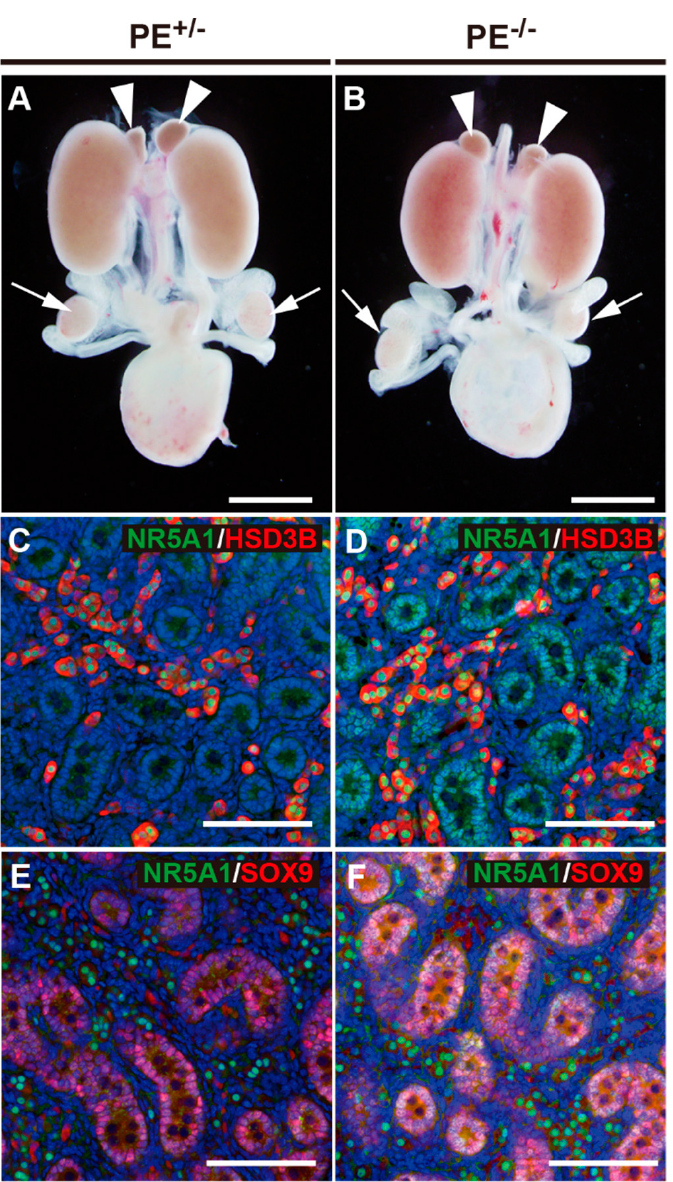
Figure 2. Fetal masculinization was not affected in PE − / − mice. ( A , B ) Macroscopic observation of the urogenital systems in the control mice ( A ) and PE − / − mice ( B ). Arrowheads indicate adrenal glands, whereas arrows indicate testes. ( C , D ) Double staining of the testis with antibodies for NR5A1 (green) and HSD3B (red). ( E , F ) Double staining of the testis with NR5A1 (green) and SOX9 (red) antibodies. Scale bar: 2 mm in ( A , B ), 100 μ m in ( C – F ).